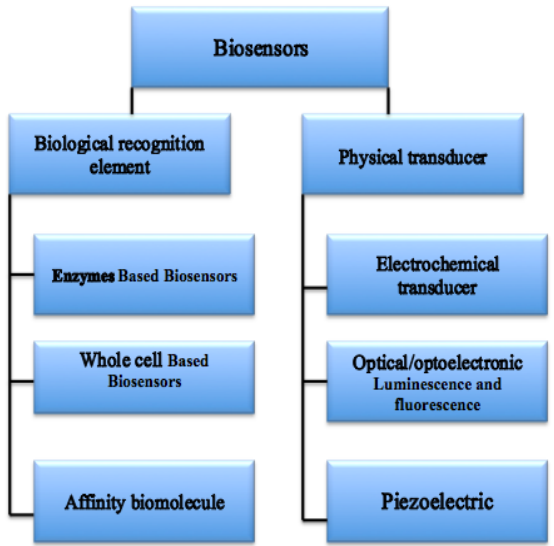
Figure 2. Schematic representation of various combinations of physical and biological elements of biosensors.